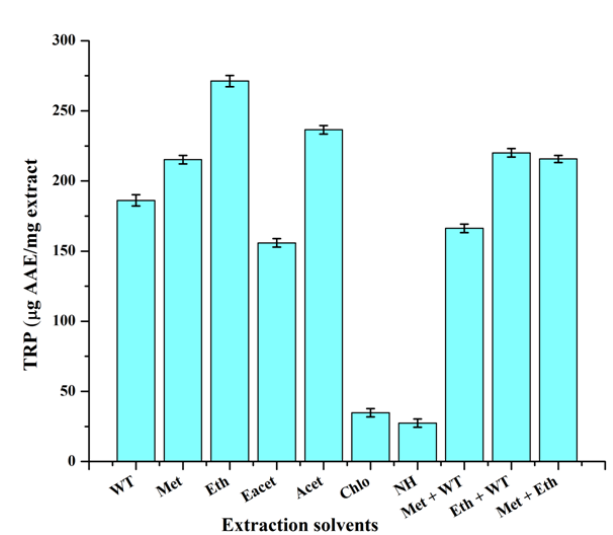
FIGURE 7 - Total reducing power of different solvent extracts of E. intermedia